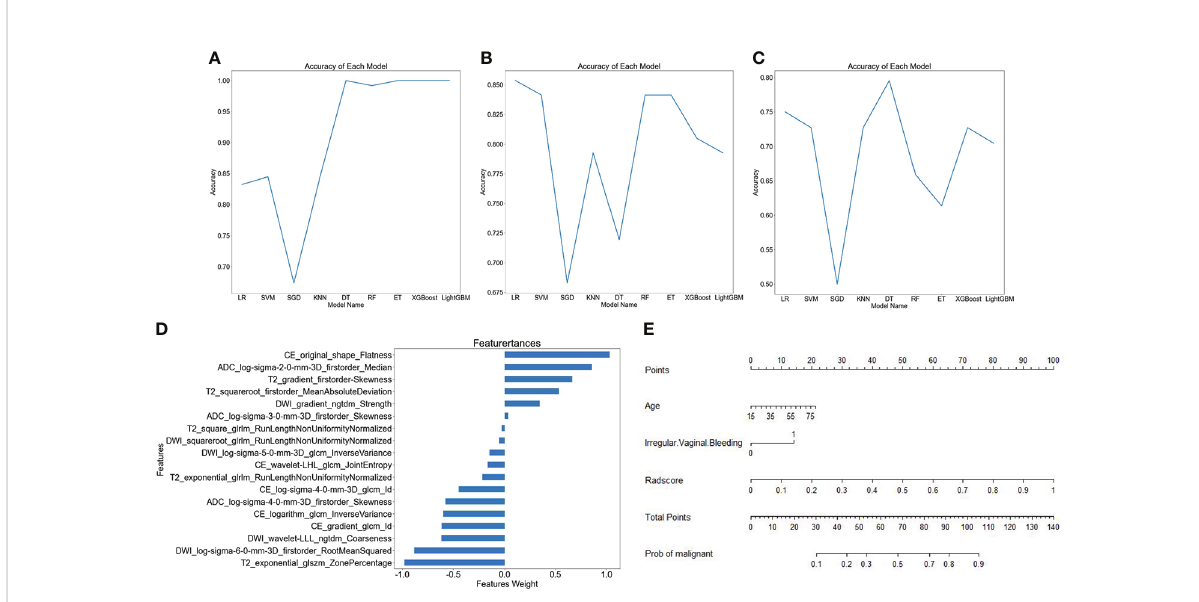
FIGURE 3 Different model building. Broken line graphs of accuracy for different machine learning algorithms in the training group (A) , the internal validation group (B) , and the external validation group (C) . Bar chart of feature weight for the logistic regression model (D) . Nomogram of the training group (E)